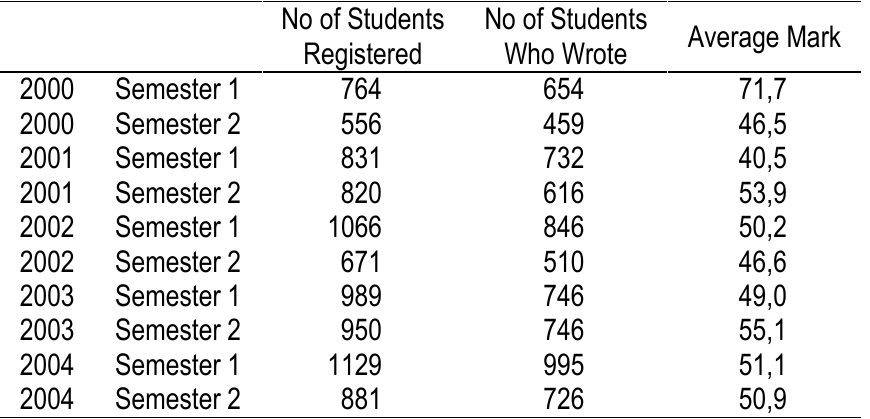
Table 1.2b. Trends in average pass mark for MNF301-5 students prior to and during compulsory assignment experiment